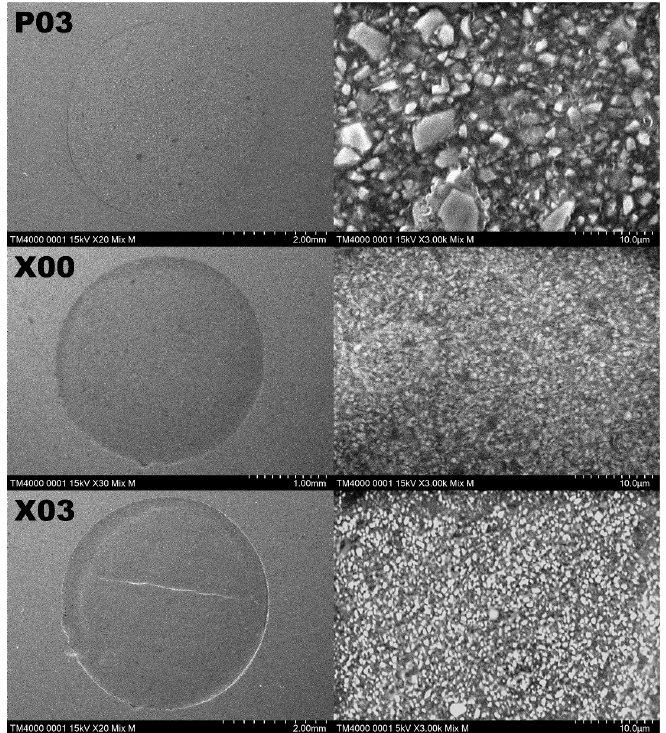
Figure 3. Scanning electron microscopic photographs of the composite materials after the wear test (magnifications: 20× (left) and 3000× (right)). The filler sizes of P03 and P00 were the largest, followed by those of F10, F03, X03, and X00, in that order. Certain indentations and convexities can be observed on the surface of the abraded specimens of P00, P03, F02, and F10, which may have resulted from filler dropout. However, all filler particles of X00 and X03 are extremely small, and the abraded surfaces are relatively flat.